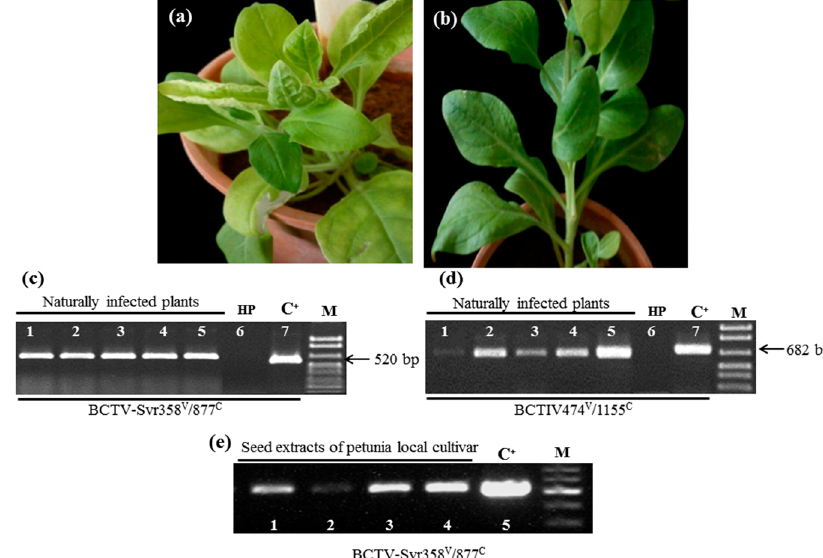
Figure 1. Detection of beet curly top virus (BCTV-Svr) and beet curly top Iran virus (BCTIV) in infected petunia plants. ( a ) Interveinal chlorosis, vein swelling and severe leaf curling in a BCTV-Svr infected petunia plant developed from the seed of the local cultivar; ( b ) non-symptomatic curly top free plant of local cultivar; ( c , d ) agarose gel electrophoresis analysis of PCR products of BCTV-Svr and BCTIV amplified from total DNA extracts of naturally infected petunia plants by specific primer pairs as indicated below each panel; ( e ) agarose gel electrophoresis analysis of PCR products of BCTV-Svr amplified from total DNA of seed extracts of petunia local cultivar by specific primer pairs as indicated below the panel. C + = Positive control: cloned DNA of BCTIV (pBin-1.4-BCTIV in D) and BCTV-Svr (pBin-1.7 BCTV-Svr in E); HP = healthy (curly top free) plant. M = Marker (DNA ladder mix, Fermentas, Waltham, MA, USA).